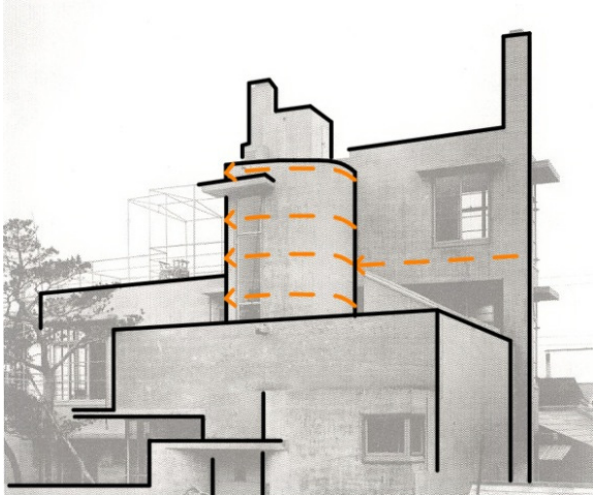
Figure 3. Sketch showing the dynamic plasticity of concrete in Reinanzaka’s House. Source: authors.